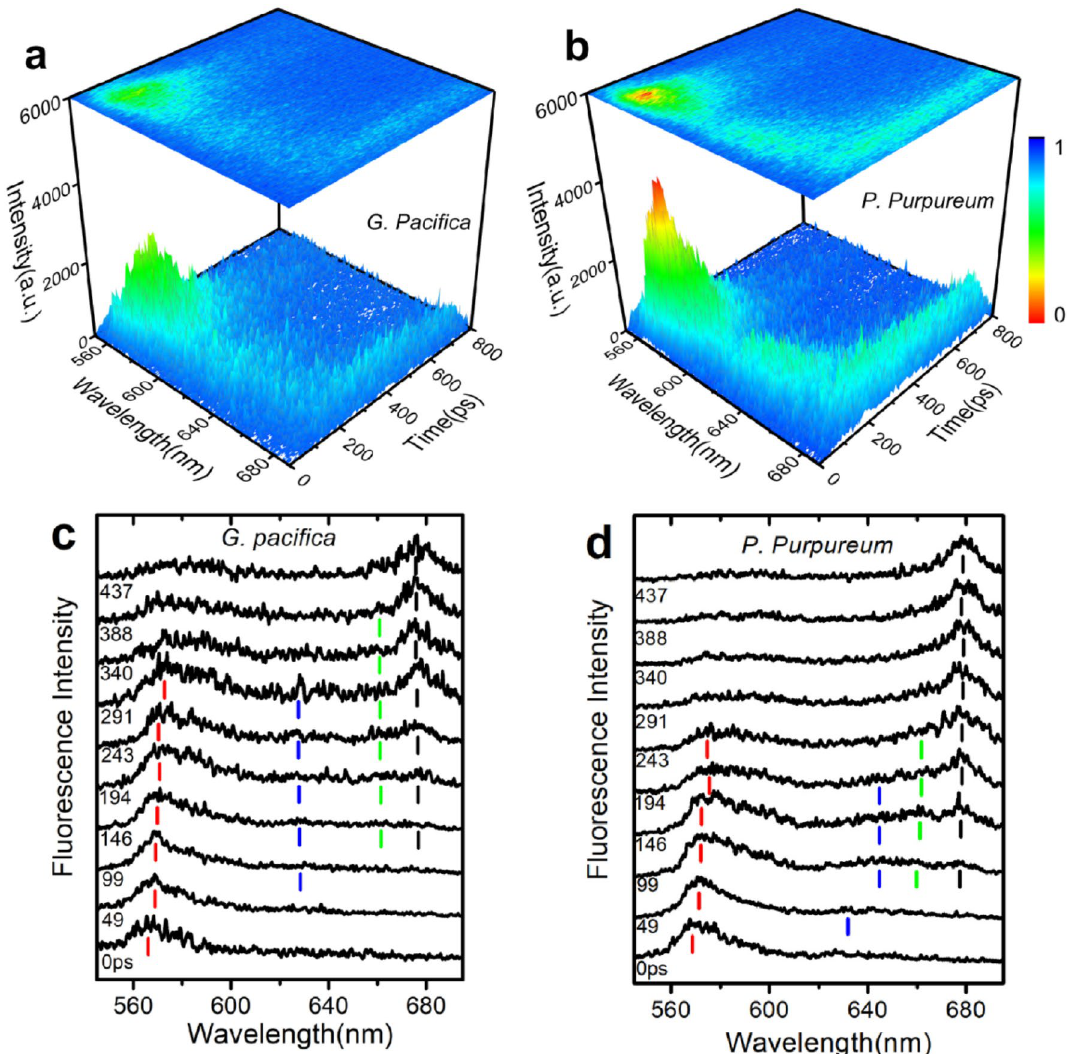
Figure 2. Time-resolved fluorescence spectra of two red algae PBSs. ( a ) Time-resolved fluorescence spectra of G. pacifica PBSs at 77 K; ( b ) Time-resolved fluorescence spectra of P. purpureum PBSs. Excitation was done at 498 nm.Fluorescence intensity is expressed as a gradation shown in the right side of the figure, and blue indicates a low intensity while red indicates a high intensity; ( c ) Normalized time-resolved fluorescence spectra of G. pacifica PBSs at 77 K; ( d ) Normalized time-resolved fluorescence spectra of P. purpureum PBSs at 77 K. Each spectrum is shown after normalization to the maximum intensity. Numbers in the figure show the time in picoseconds after